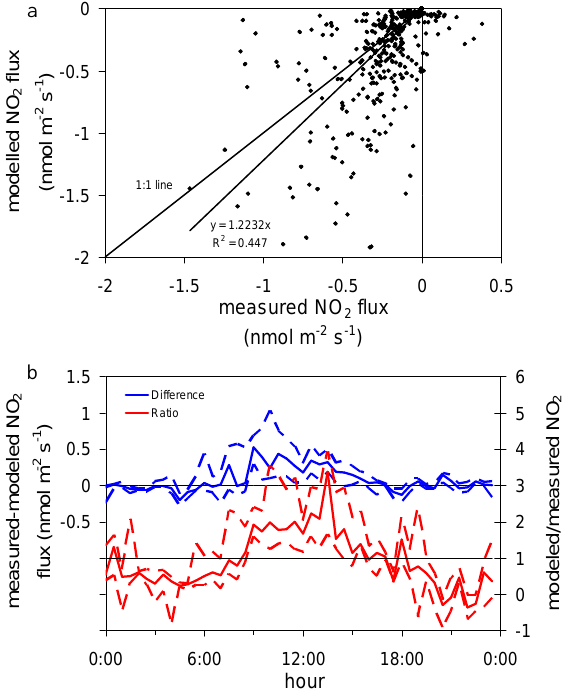
Fig. 5. (a) Comparison between measured and modelled NO 2 fluxes. (b) Half-hourly median (solid lines) and interquartile range (dotted lines) of the difference (blue lines) and ratio (red lines) between measured and modelled NO 2 fluxes from 29 August to 20 September 2005. cant scatter ( R 2 = 0 . 45) and a large deviation (slope =